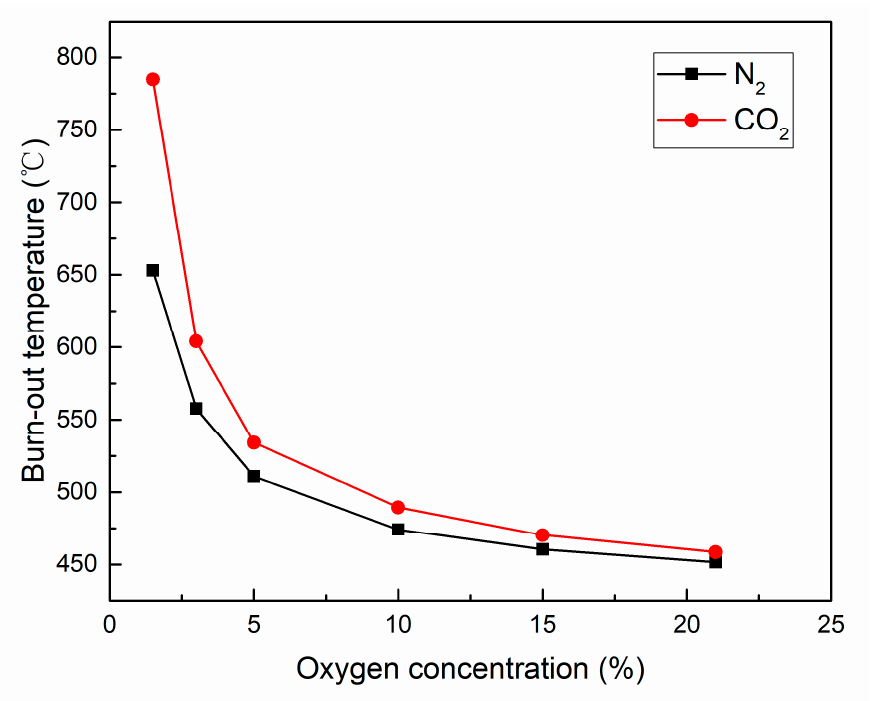
Figure 10. Burn-out temperature of coal sample in the N 2 and CO 2 atmospheres.